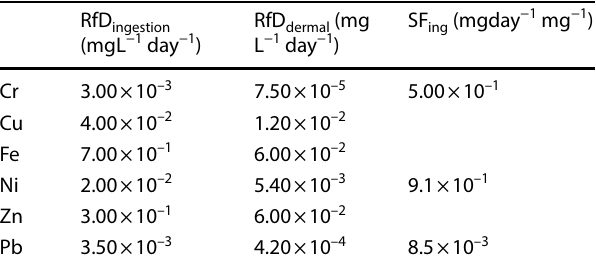
Table 3 Oral reference dose (RfD) and Slope factor (SF) of the PTE used in this study [25, 28]